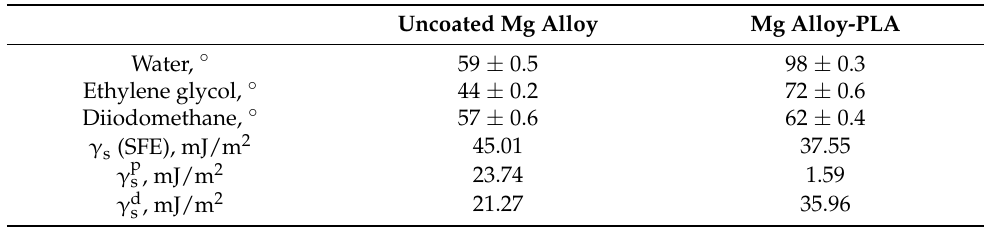
Table 4. Values of contact angle, and surface free